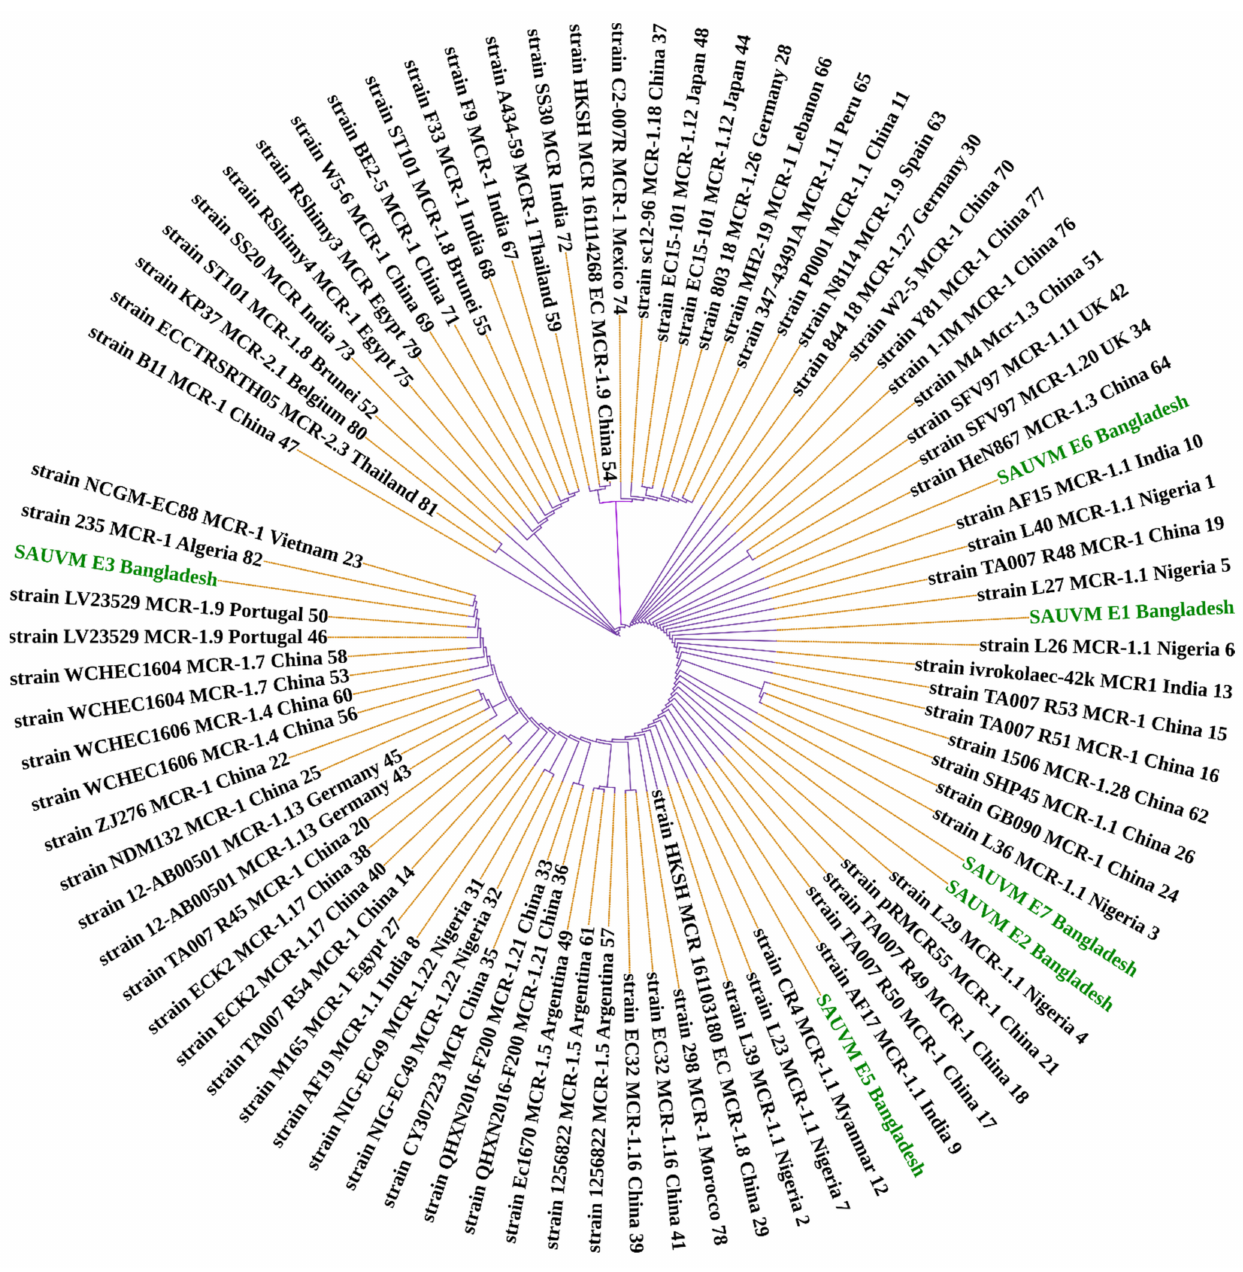
Figure 2. Phylogeny of 91 MCR-1 proteins of E. coli origin retrieved from NCBI database includ- ing the six sequenced SAUVM MCR-1 genes from this study. Phylogenetic study of MCR-1 and MCR-1-like proteins reveals ancestral origins and diversification. Using amino acid sequences from six SAUVM MCR-1 proteins, the BLAST search tool (https://blast.ncbi.nlm.nih.gov/Blast.cgi ac- cessed on 16 March 2021) was used to retrieve homologous sequences of MCR-1 and MCR-1-like proteins from the NCBI database. MCR-1 and MCR-1-like proteins of Salmonella , E. coli , strains containing LptA (formerly known as EptA), and other sequences were categorized. Using aligned MCR-1 sequences from CLUSTALW, the maximum likelihood method of MEGA X was used to create a phylogenetic